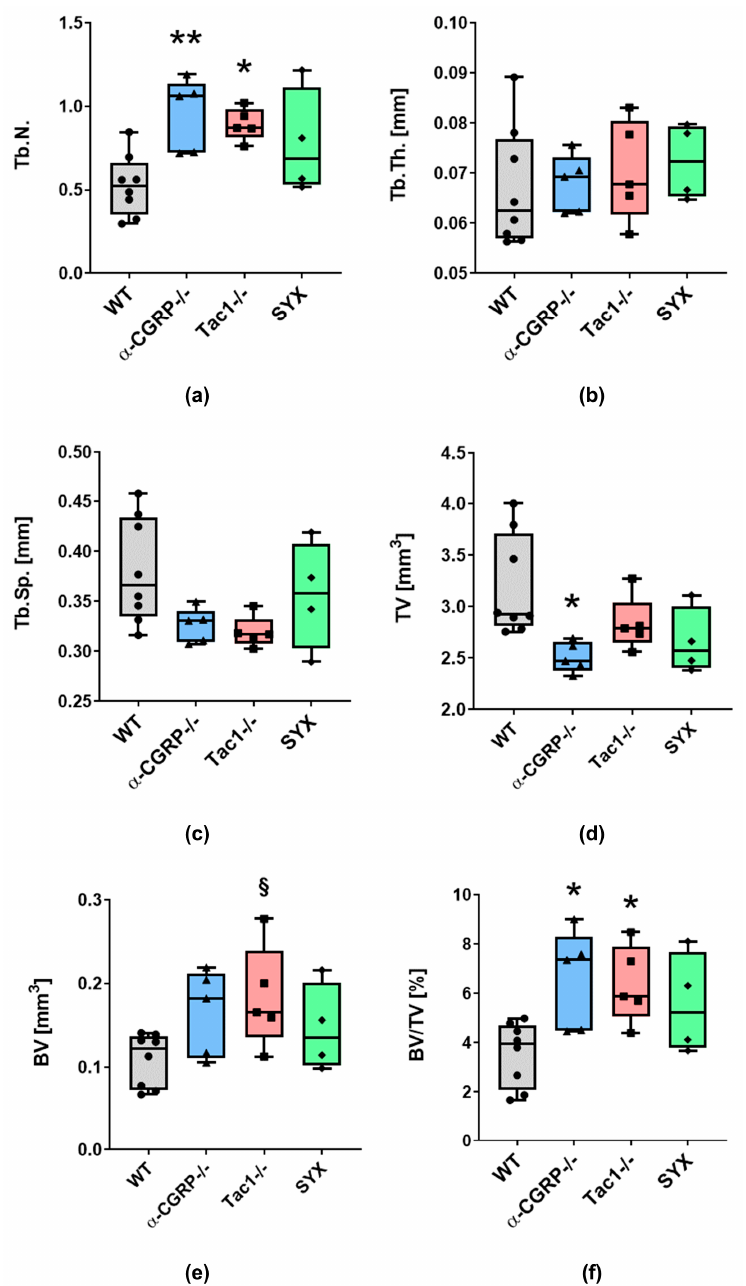
Figure 3. µ CT analysis of the trabecular bone in the distal part of the contralateral non-fractured femora of WT, α -CGRP − / − , Tac1 − / − and SYX mice at 21 days after fracture. ( a – c ) Trabecular bone properties. Trabecular number ( a ), thickness ( b ) and separation ( c ) of the trabecular bone in the distal region of the contralateral non-fractured femora. ( d ) Total volume (TV) of the trabecular bone in the distal region of the contralateral non-fractured femora. ( e ) Bone volume (BV) of the trabecular bone in the distal region of the contralateral non-fractured femora. ( f ) Bone volume/total volume (BV/TV) of the trabecular bone in the distal region of the contralateral non-fractured femora. * indicates differences between neurotransmitter-deficient groups and WT animals. * = p ≤ 0.05; ** = p < 0.01 § indicates a trend compared to WT, § = p = 0.0614. (nWT = 8, nCGRP − / − = 5, nTac1 − / − = 5, nSYX = 4).